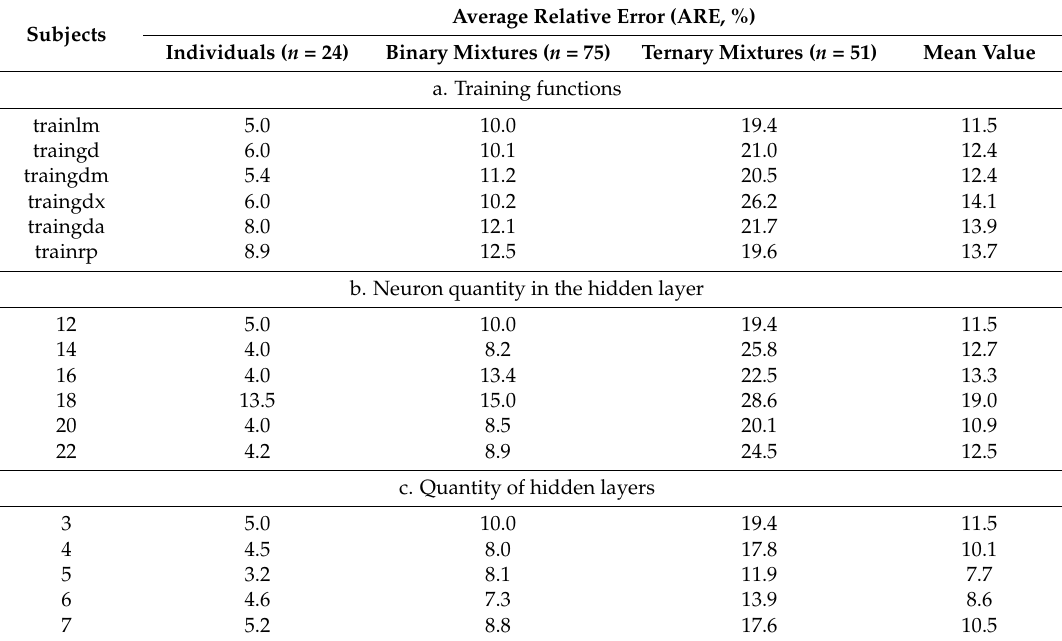
Table 3. The average relative error of BP neural network with different parameters.